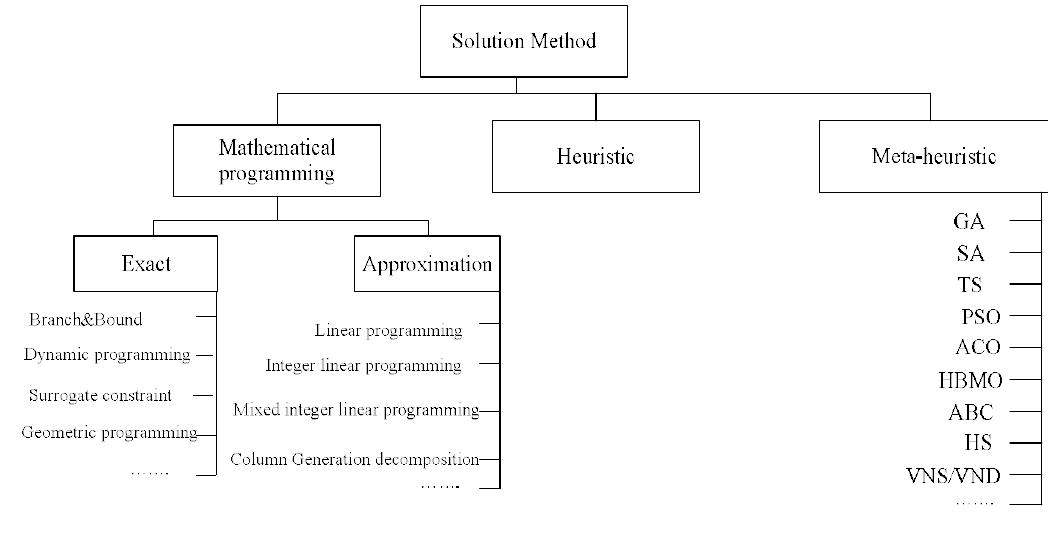
Fig. 3. RAP solution